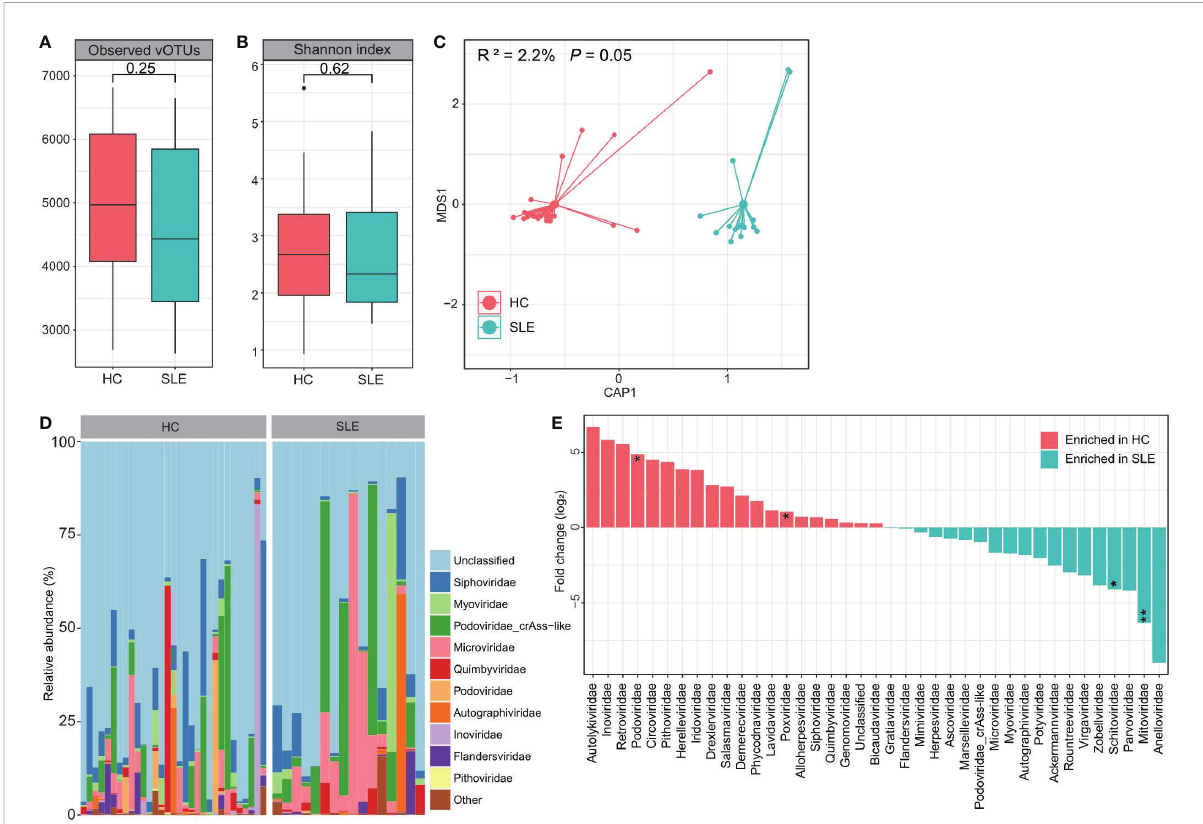
FIGURE 3 Difference of VLP-based gut virome between SLE patients and healthy controls. (A, B) Boxplot showing the observed number of vOTUs (A) and Shannon diversity index (B) between two groups. The signi fi cance level is calculated using the Student ’ s t test. (C) dbRDA analysis based on the gut viral composition at the vOTU level reveals the separations between SLE patients and healthy controls. The location of samples (represented by fi lled nodes) in the fi rst two multidimensional scales are shown. Lines connect samples that belonged to the same group. (D) Composition of VLP-based gut virome at the family level. (E) Barplot showing the fold changes of viral families when compared between patients and controls. The signi fi cance level in the Wilcoxon rank-sum test is denoted as: * adjusted P < 0.05, ** adjusted P <